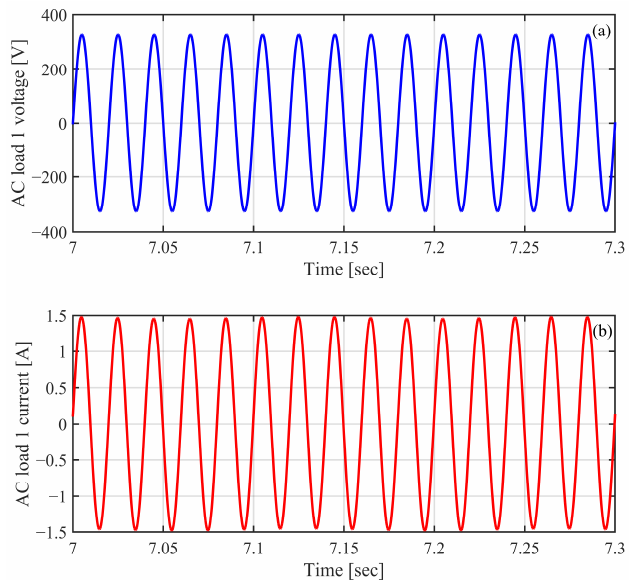
Figure 21. AC load 1 voltage ( a ) and current ( b ) of the LVAC distribution.